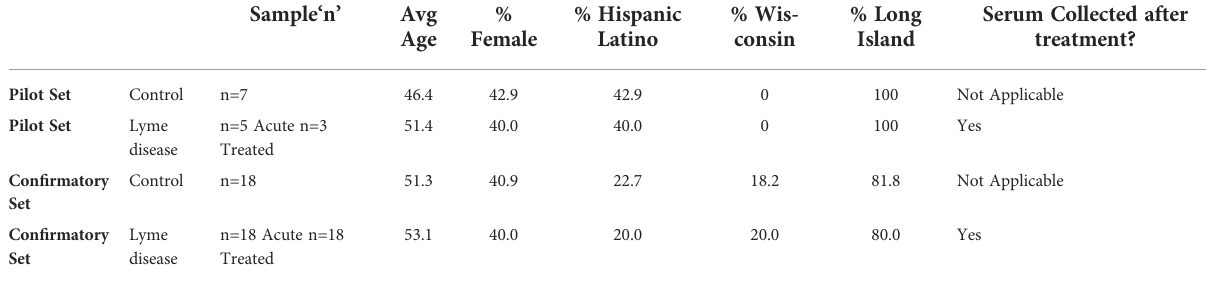
TABLE 2 Patient Samples.